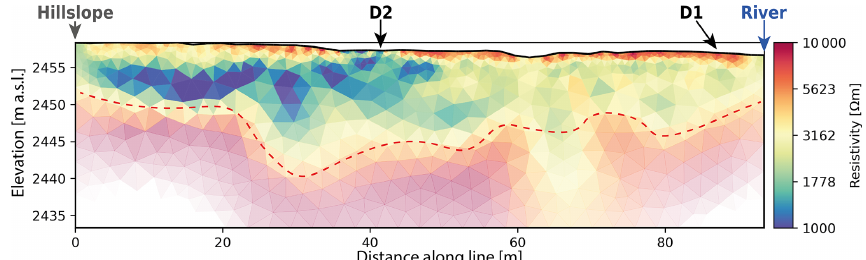
Figure 7. Results of one ERT profile perpendicular to the stream at the location of groundwater wells D1 and D2 (see Fig. 2). The electrode array consists of 48 electrodes with 2m spacing. Robust inversion was performed for the dipole–dipole scheme using a regularization coefficient lambda of 10. Location of groundwater wells as well as the hillslope and river sides are also highlighted. The red dashed line shows the limit between water-filled sediments and the underlying